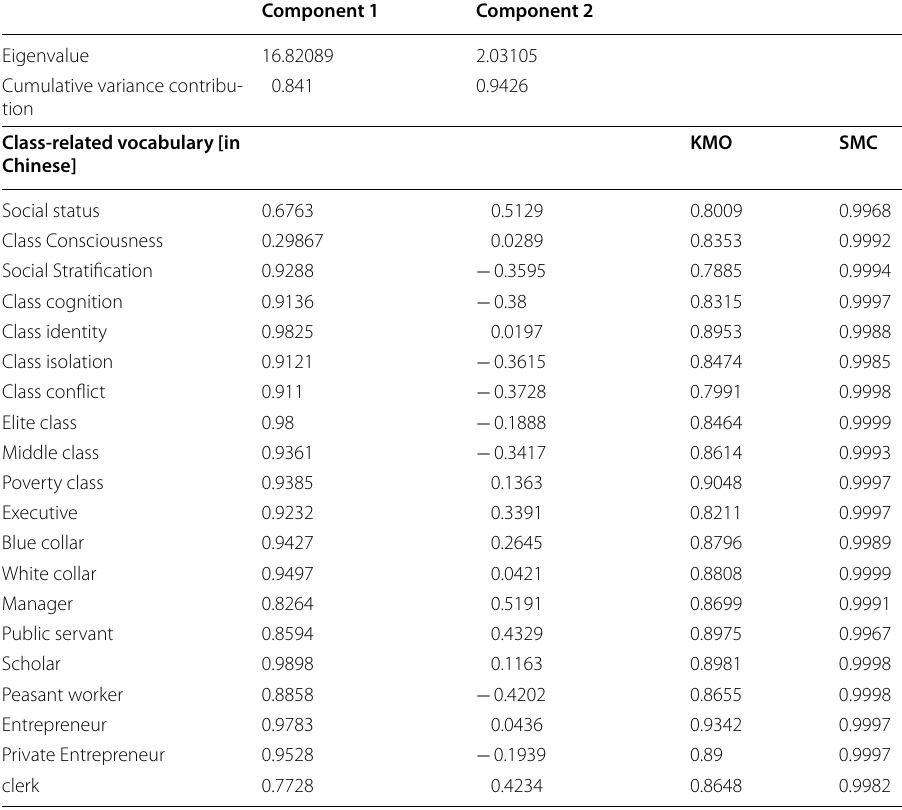
Table 2 Result of principal component analysis for stratum-related